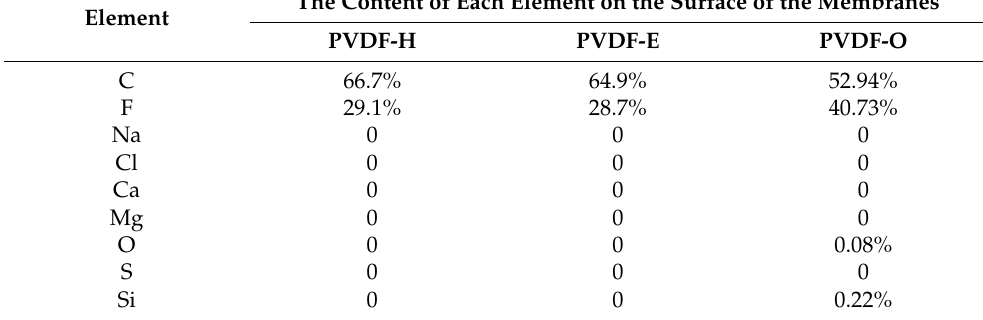
Table 5. The content of each element on the surface of PVDF-H, PVDF-E and PVDF-O membranes tested by EDS.